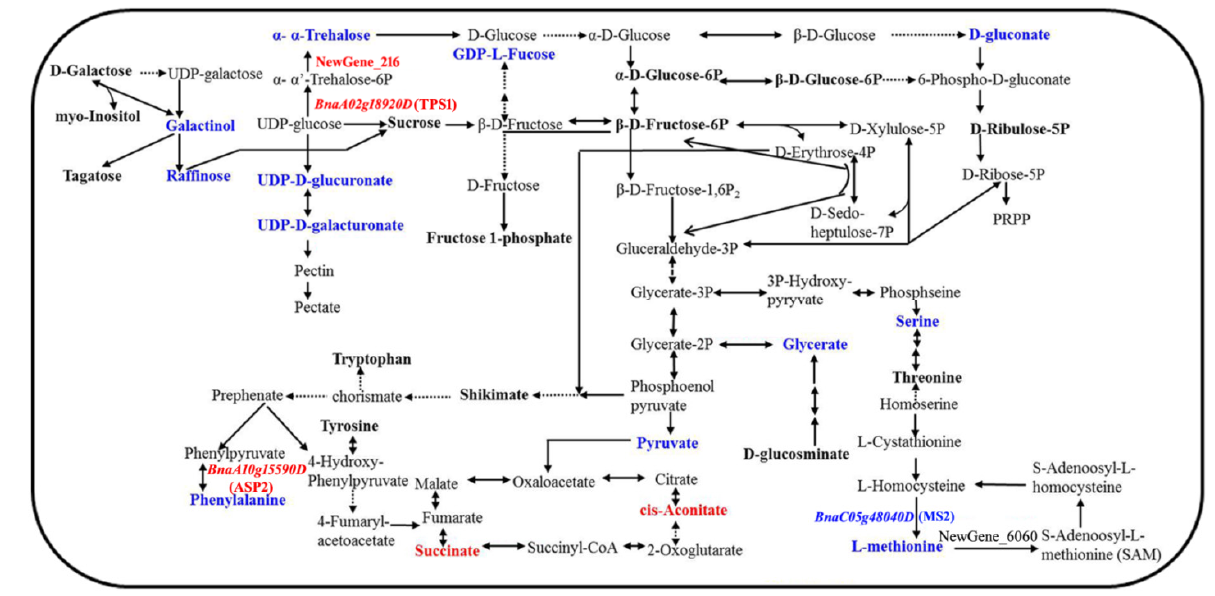
Figure 6. Metabolic pathway of lignocellulose by integrating DEGs, differentially accumulated metabolites between ZY821 and YG689. Red marks indicate up-regulated genes or up-accumulated metabolites in the pathway of lignocellulose synthesis. Blue marks indicate down-regulated genes or down-accumulated metabolites in the pathway of lignocellulose synthesis. NewGene_216 and NewGene_6060 are predicted new genes for B. napus by transcriptome analysis.